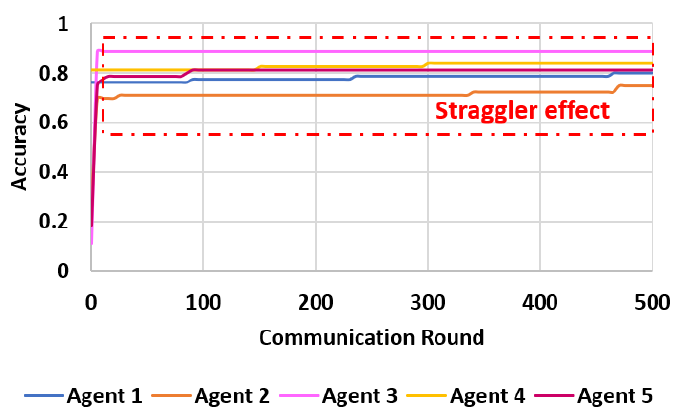
Figure 12. Straggler effects on participating FL agents’ (three agents and two stragglers) model accuracy for the prediction of agents’ resource-sharing capability.